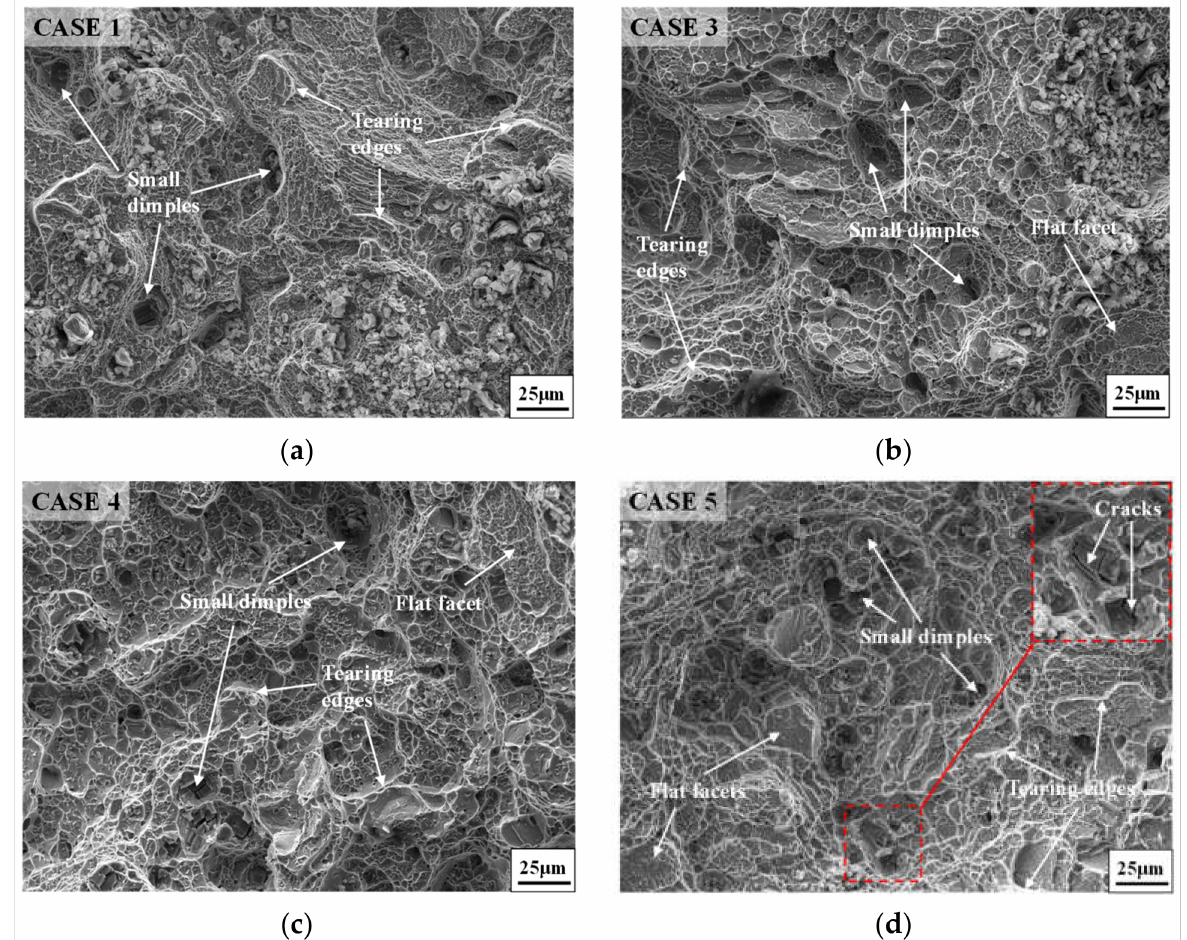
Figure 4. Fracture morphologies of ( a ) hot-upsetting sample; and annealed samples with different FSA times: ( b ) 9 h; ( c ) 12 h; ( d ) 24